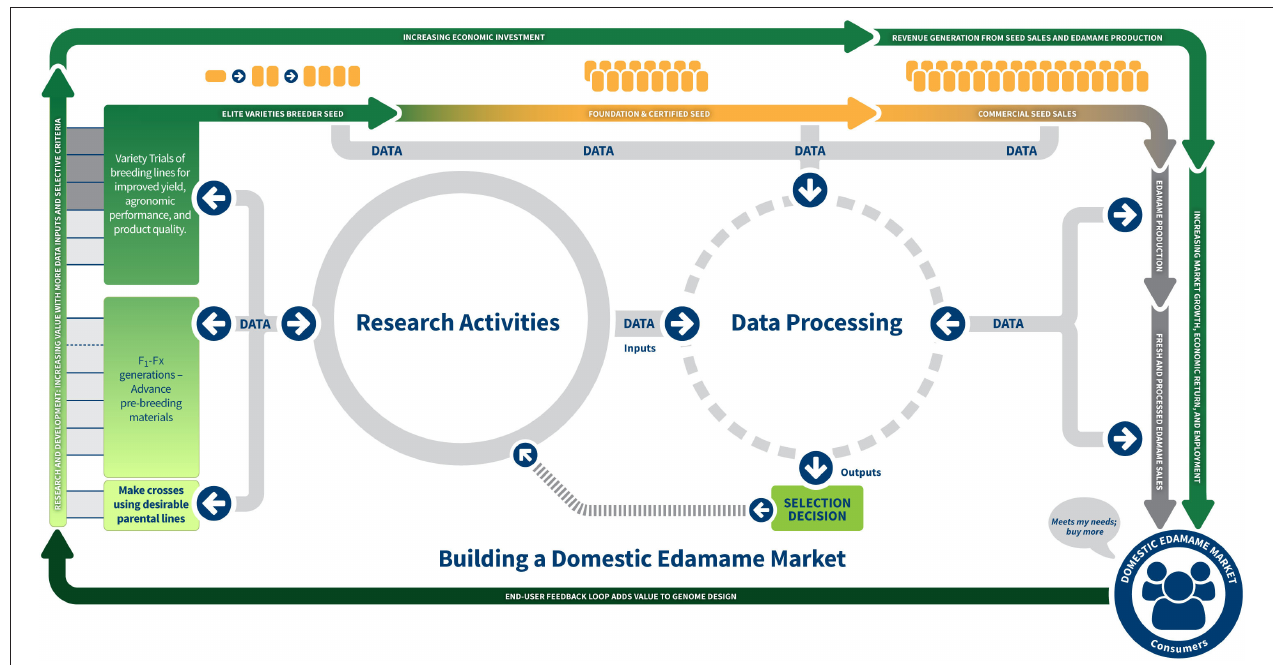
FIGURE 1 | General framework for building a domestic edamame market: Data integration and value chain relationship throughout the agricultural and food